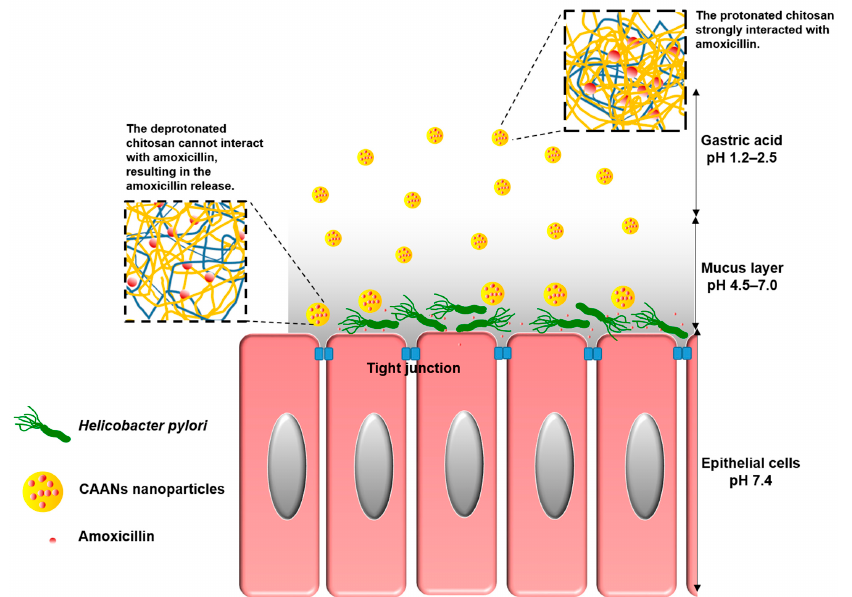
Scheme 1. Schematic illustration showing that CAANs are stable in the gastric acid of the gastric lumen; they penetrate the mucus layer, become unstable, and then release the amoxicillin at the site of H. pylori